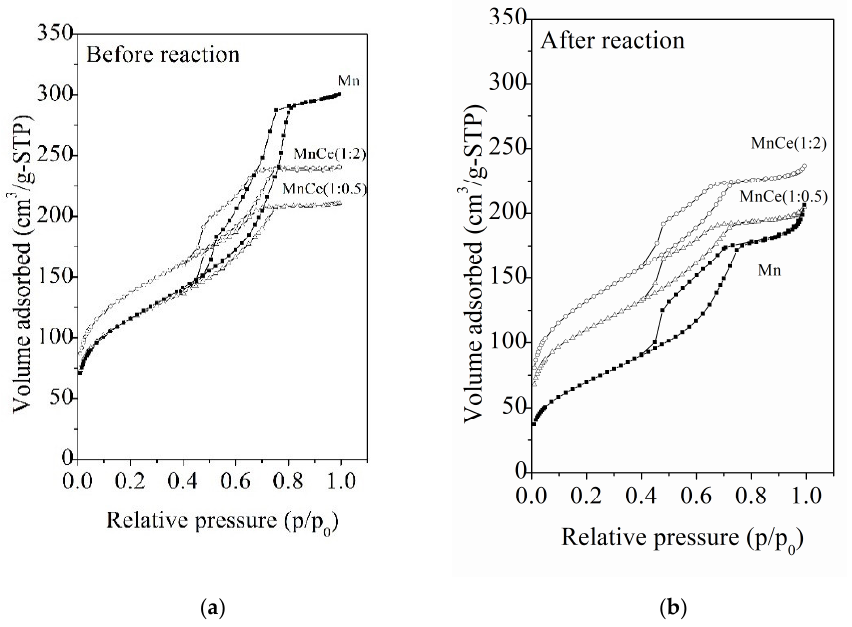
Figure 2. Nitrogen adsorption–desorption isotherms of the catalysts before ( a ) and after ( b ) the VOC combustion.